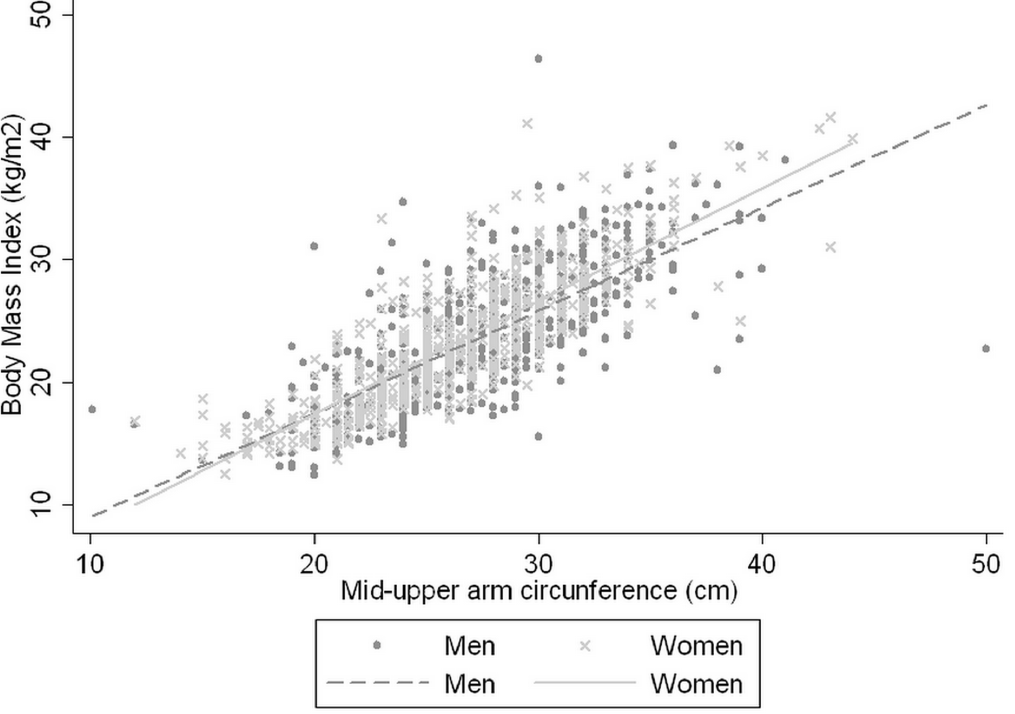
Fig 2. Relationship between Mid-Upper Arm Circumference and Body Mass Index in women and